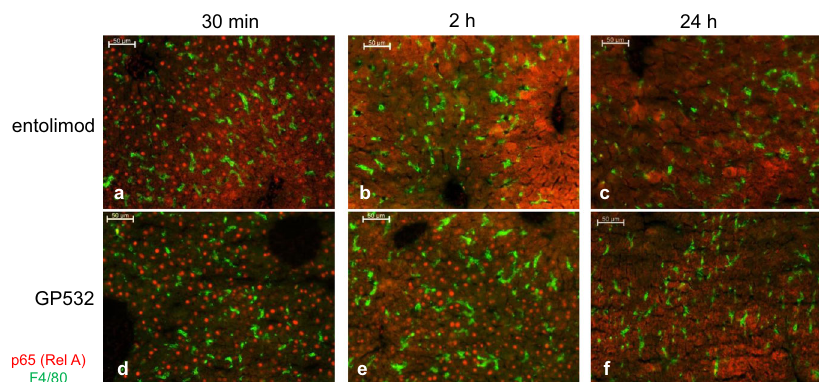
Fig. 7 Dynamics of NF- κ B activation in mouse liver hepatocytes following s.c. injection of entolimod or GP532. C57BL/6 mice were injected with entolimod ( a – c ) or GP532 ( d – f ) s.c. (1 μ g/injection). Livers were harvested at 30 min ( a , d ), 2 h ( b , e ), or 24 h ( c , f ) post-injection. NF- κ B activation was monitored by immunohistochemical visualization of NF- κ B p65 subunit nuclear translocation (as in 4 ). Red – p65 (RelA); green – F4/80 (macrophage biomarker). Nuclear localization of p65 is indicated by a punctuate staining pattern. Scale bar = 50 μ m in all panels.